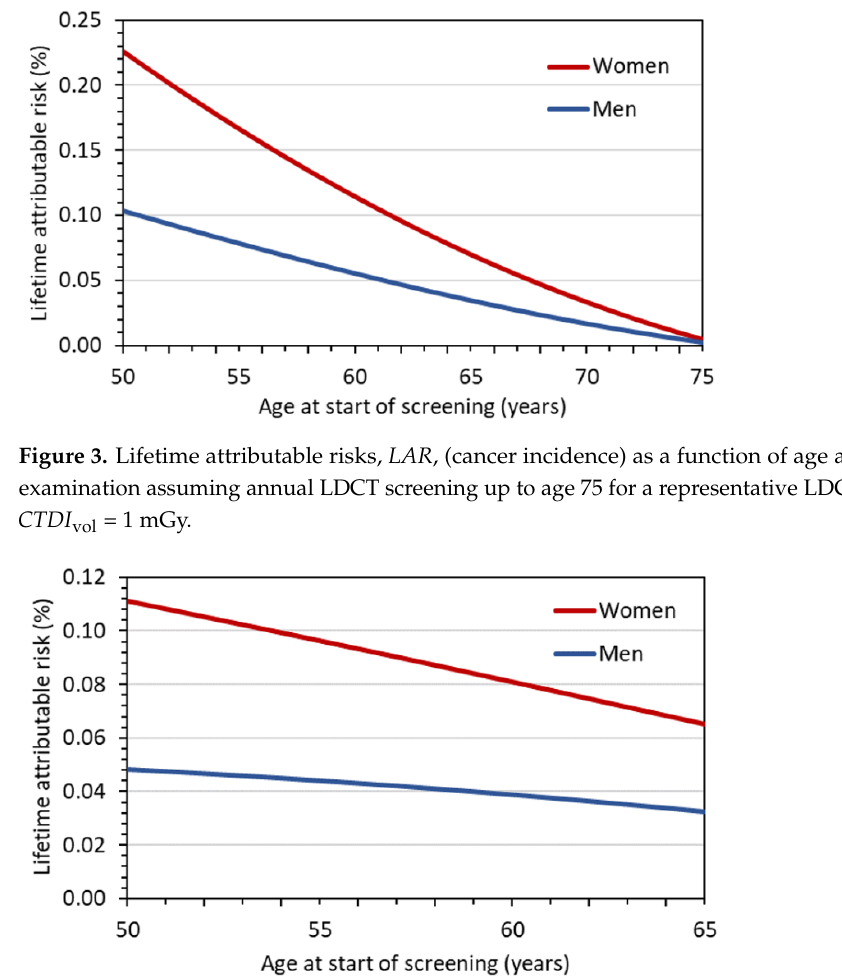
Figure 4. Lifetime attributable risks, LAR , (cancer incidence) as a function of age at first screening examination assuming annual LDCT screening over ten years for a representative LDCT protocol with CTDI vol = 1 mGy.